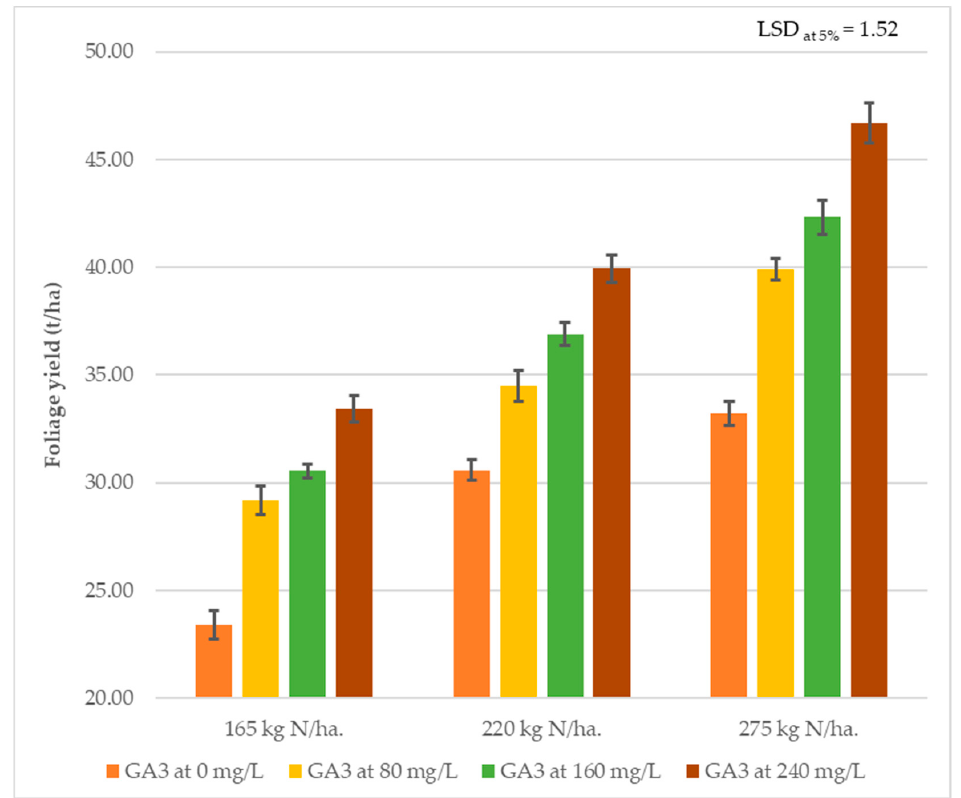
Figure 8. Foliage yield (t/ha) as affected by the interaction between nitrogen fertilizer levels and GA 3 spraying concentra- tions in the second season